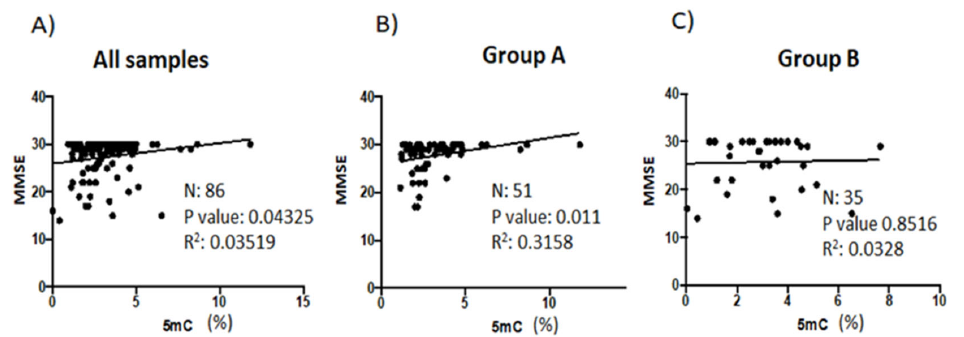
Figure 5. Correlation analyses of the relationship between patient MMSE scores and levels of global DNA methylation during clinical follow ‐ up. ( A ) The association between MMSE scores and 5mC levels in ( A ) all patients ( n = 86), ( B ) patients in Group A ( n = 51), and ( C ) patients in Group B ( n = 35). Data points indicate individual patient values. Pearson correlation was used to establish statistical correlation. 5mC, 5 ‐ methylcytosine; MMSE, Basal Mini ‐ Mental State Examination. The ADAS scale comprises cognitive (ADAS ‐ Cog) and non ‐ cognitive (ADAS ‐ Non ‐ cog) sections. The ADAS ‐ Cog test assesses the main components of cognitive function and allows for the evaluation of the efficacy of pharmacologic interventions against dementia.